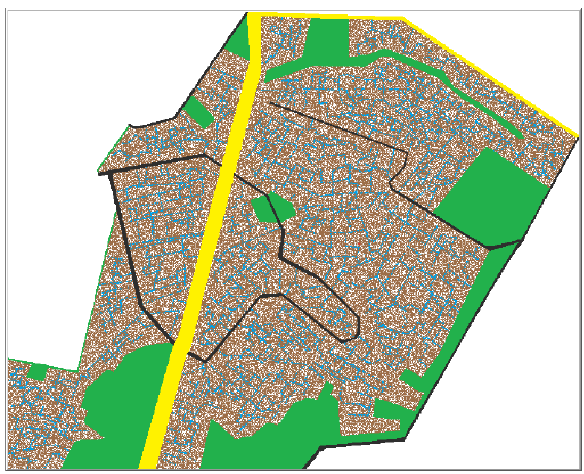
Figure 2. A ready-to-run simulation after post-processing Figure 1 and initialization.